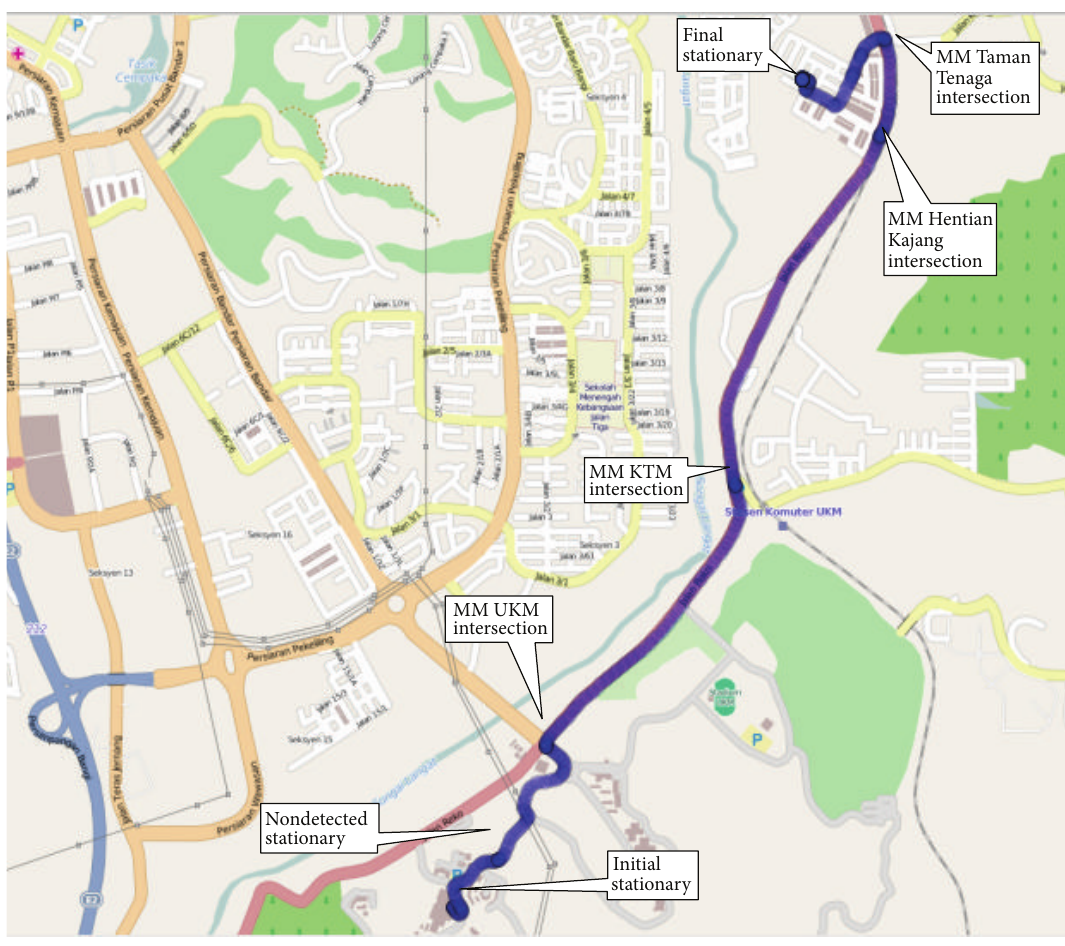
Figure 10: First test run in Jalan Reko, Kajang, Selangor, Malaysia, plotted in QGIS.